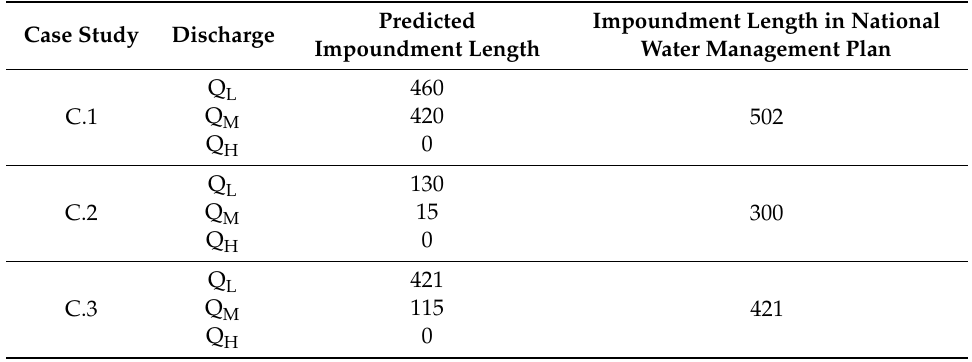
Table 6. Comparison of the predicted impoundment length (m), according to the overall assessment method, and the published length, according to the National Water Management